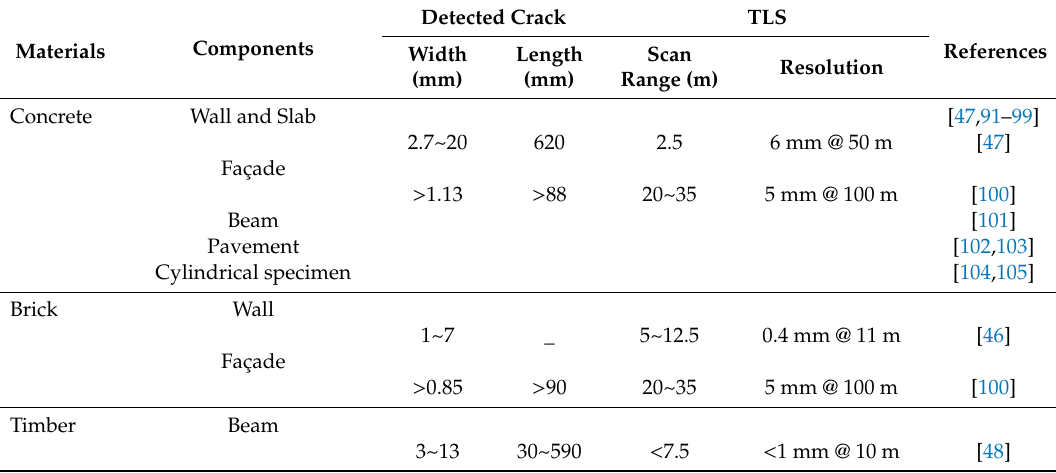
Figure 7. Crack characterization using integrated laser scanning and image processing: ( a ) identified Figure7. Crackcharacterizationusingintegratedlaserscanningandimageprocessing: ( a )identifiedcritical critical region; ( b ) 3D model of critical region [47]. region; ( b ) 3D model of critical region [47]. Table 5. Examples of crack detections in di ff erent Table 5. Examples of crack detections in different components.